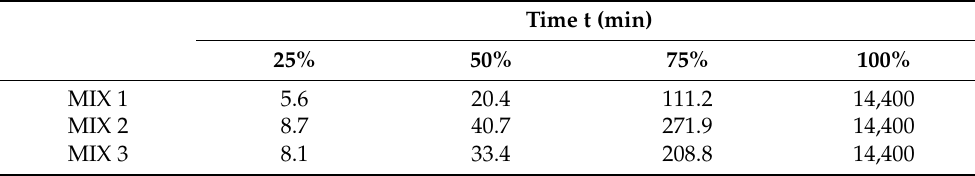
Table 4. Summary of approximate time t for the target saturation degree of specimens (25%, 50%, 75% and 100%) determined from the estimated saturation curves for the MIX 1, 2 and 3 concrete